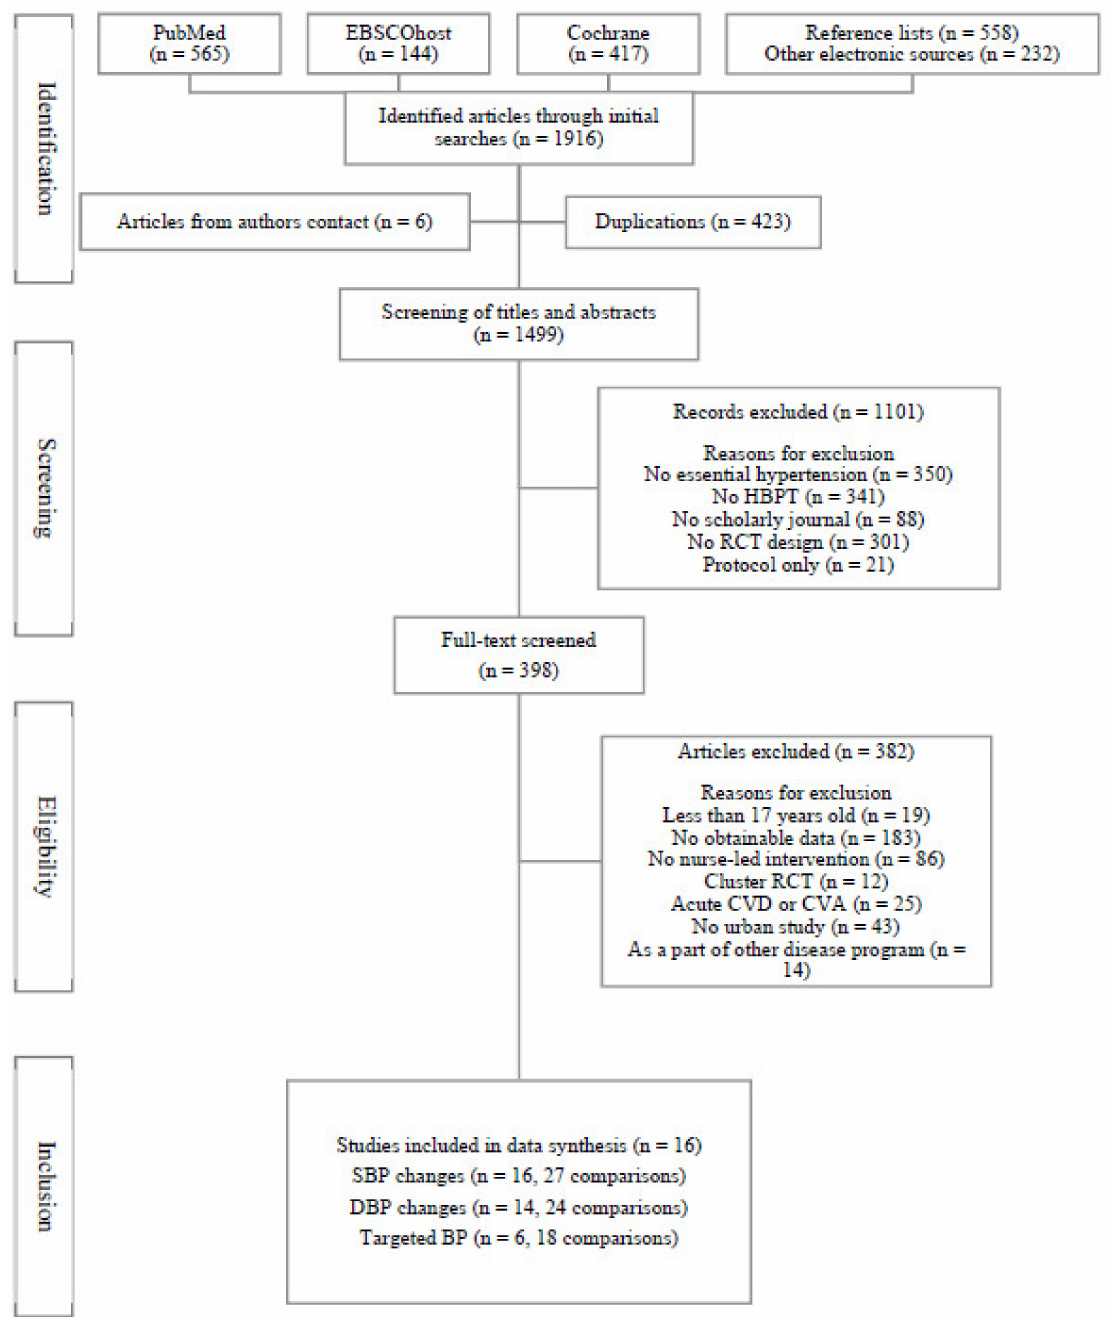
Figure 1. PRISMA flow diagram of the selection of studies included in the systematic review. Note. HBPT, home blood pressure telemonitoring; RCT, randomized controlled trial; CVD, cardiovascular disease; CVA, cerebrovascular accident; SBP, systolic blood pressure; DBP, diastolic blood pressure; BP, blood